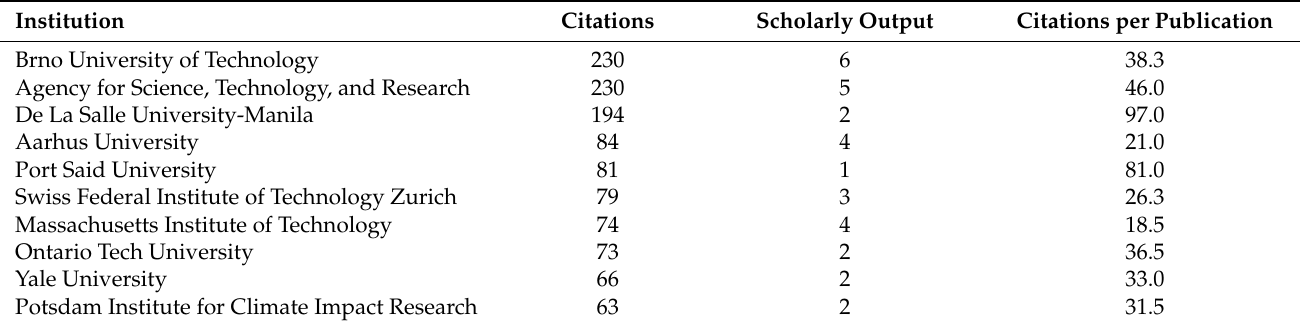
Table 3. Top 10 institutions by the number of citations in Scopus within energy (subject area: renewable energy, sustainability, and the environment),